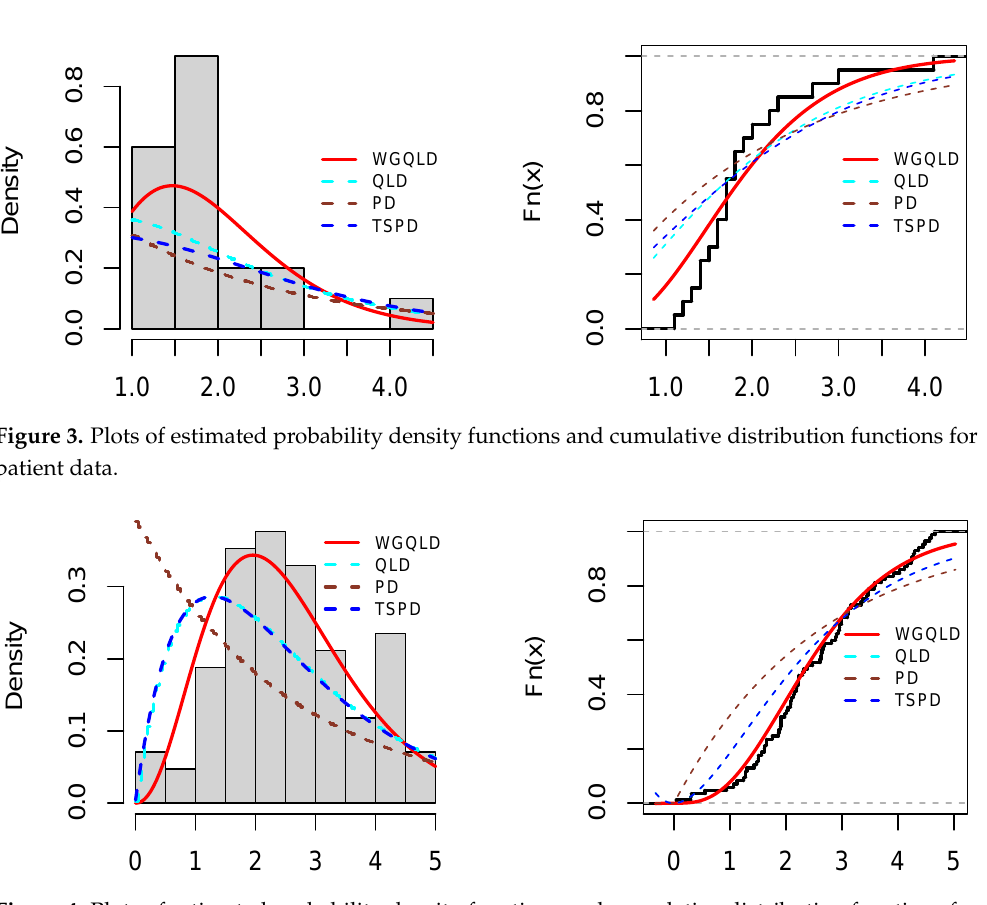
Figure 4. Plots of estimated probability density functions and cumulative distribution functions for aircraft windshield data. Table 7. The measures AIC, AICc, BIC, HQIC, and K-S with the corresponding p -value for rain data.